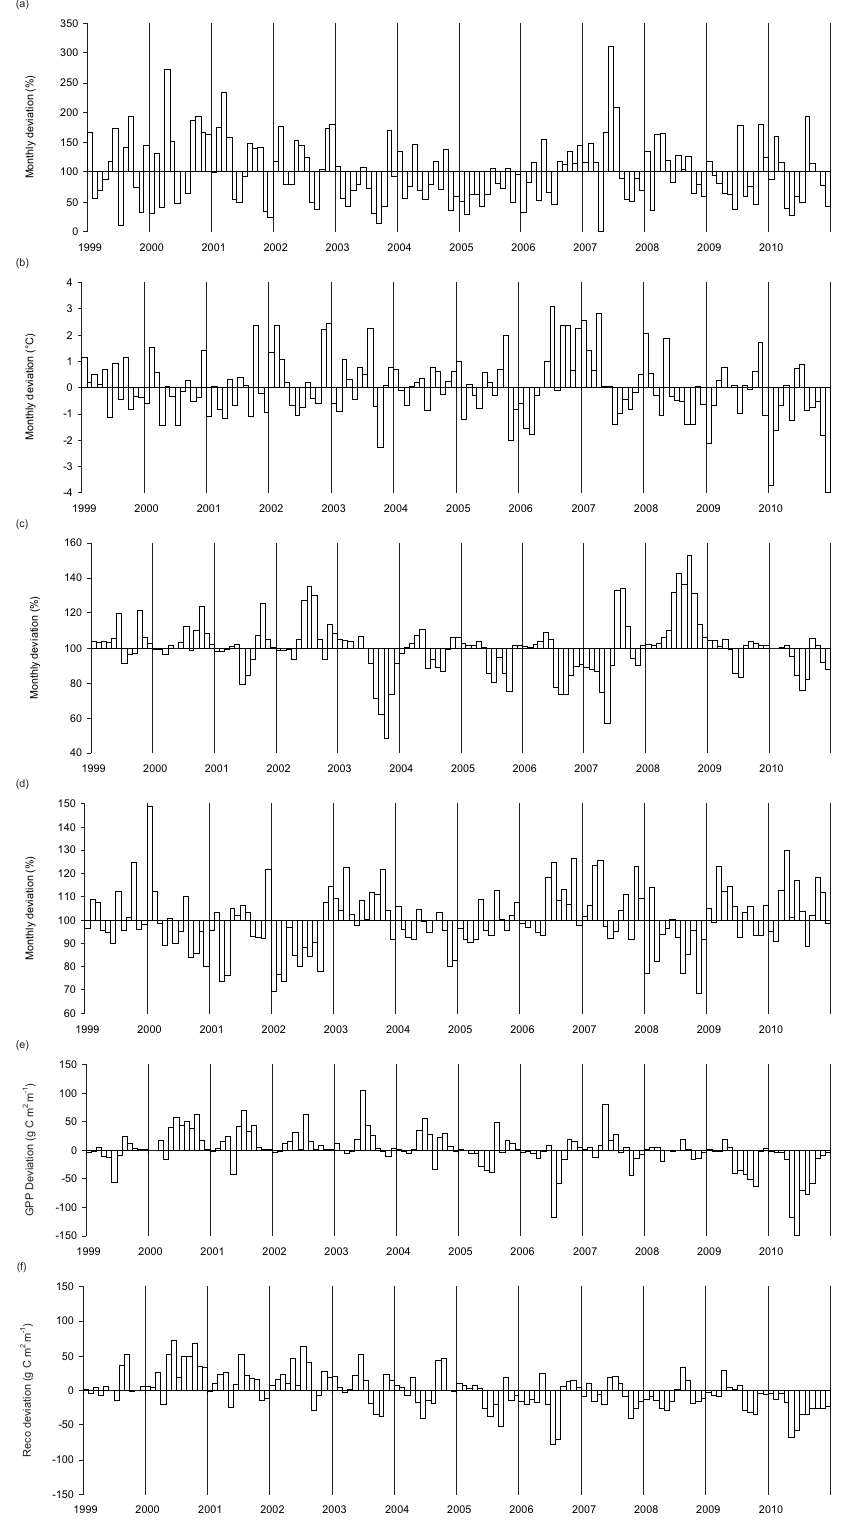
Fig. 6. Deviation from the 12-yr monthly average (1999–2010) for key climatic variables and partitioned CO 2 flux components at the oak plantation woodland, Straits Inclosure, Alice Holt Forest: (a) precipitation, (b) air temperature, (c) soil moisture, (d) solar radiation, (e) GPP and (f) R eco